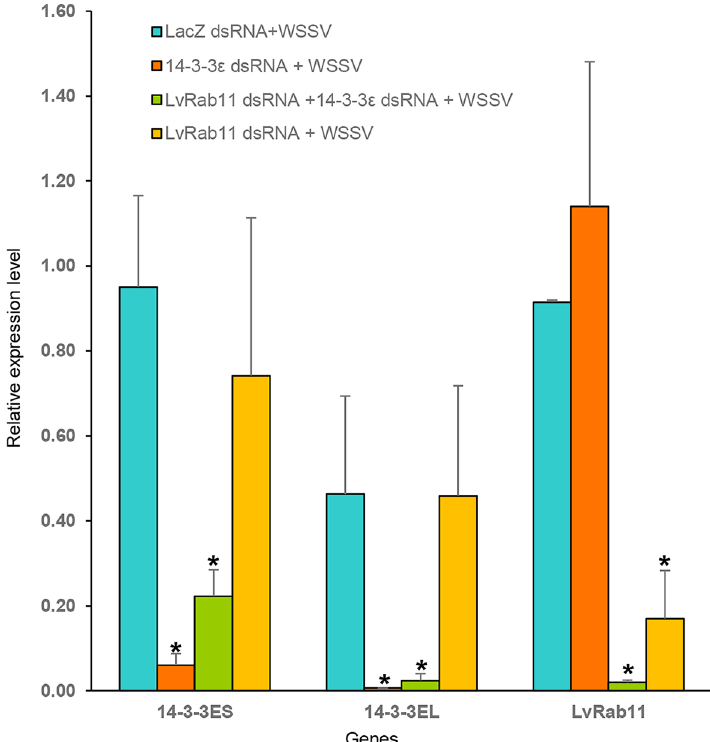
Figure 8. Suppression of LvRab11 and 14-3-3ε in shrimp during WSSV infection. Expression level of LvRab11 and 14-3-3ε was detected from the gill of the shrimps injected with 20 μg of each dsRNA following WSSV infection. The data represent means ± standard deviations, n = 3/group. Asterisks indicate significant differences ( p < 0.05) compared with the values for the